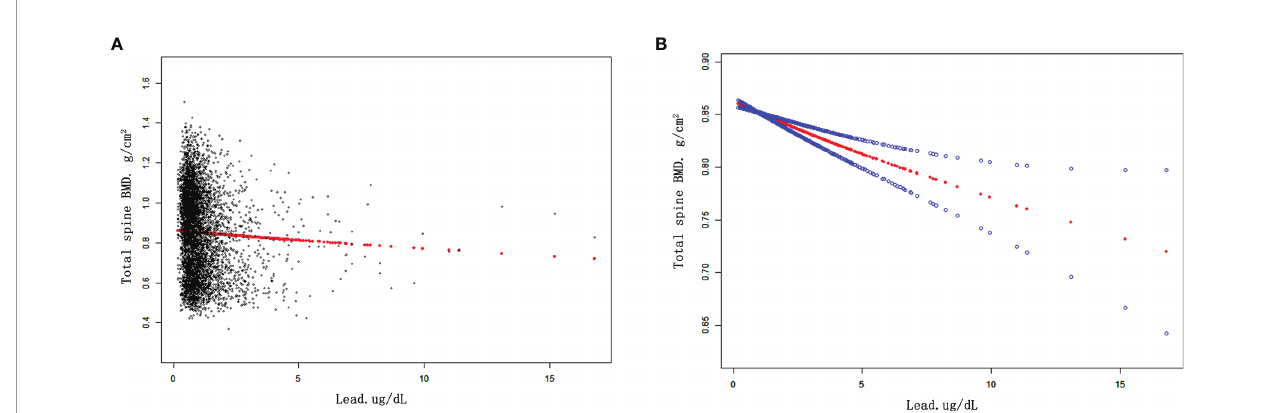
FIGURE 1 | The associations between BLL and total spine BMD. (A) Each black point represents a sample. (B) Red line represents the smooth curve fi t between variables. Blue lines represent the 95% of con fi dence interval from the fi t. Age, gender, race/ethnicity, PIR, BMI, serum calcium, serum phosphorus were adjusted.